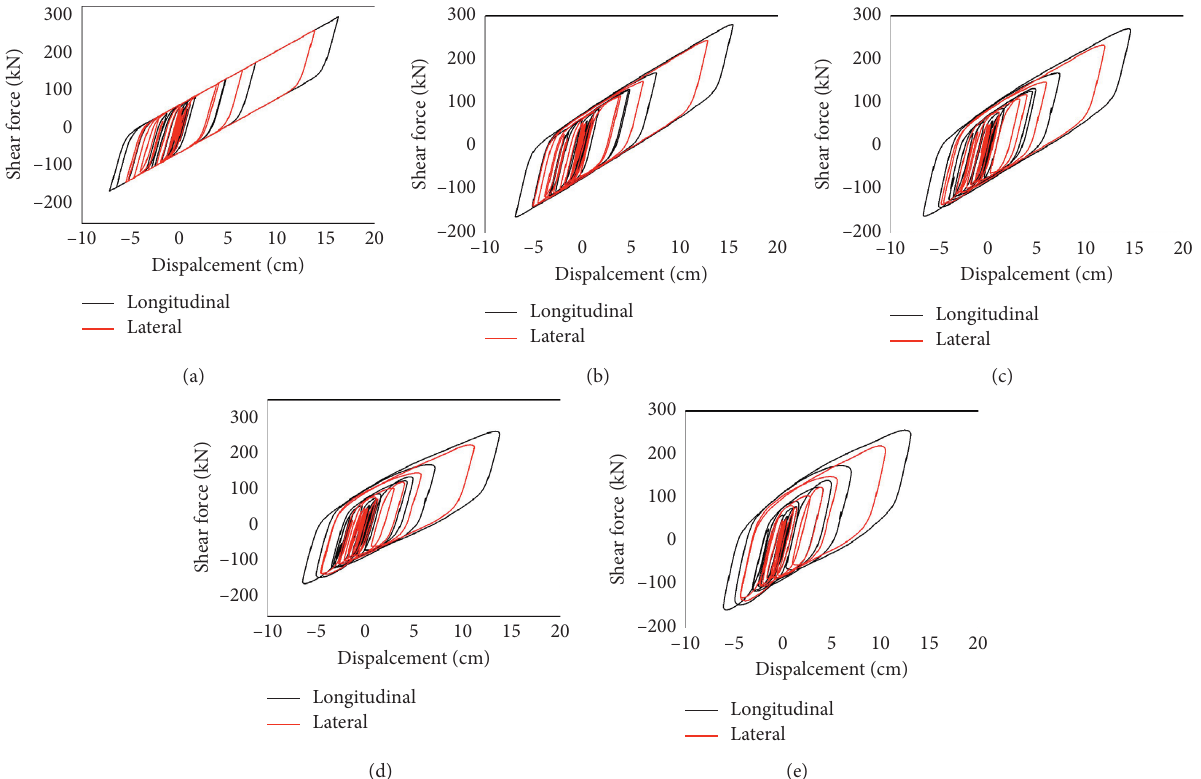
Figure 6: Hysteretic curves of HDR bearings with different dampings: (a) 0kN · s/m; (b) 20kN · s/m; (c) 40kN · s/m; (d) 60kN · s/m; (e) 80kN · s/m.